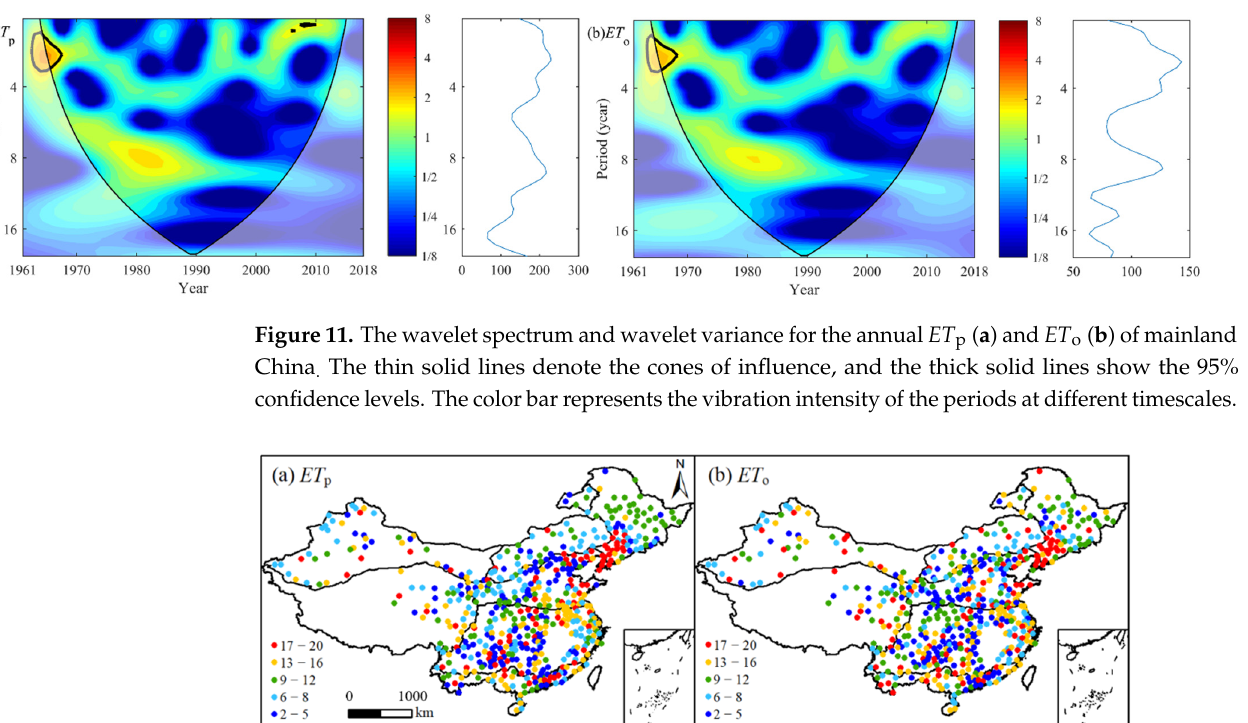
Figure 12. The main periods of annual ET p ( a ) and ET o ( b ) extracted from wavelet analysis.